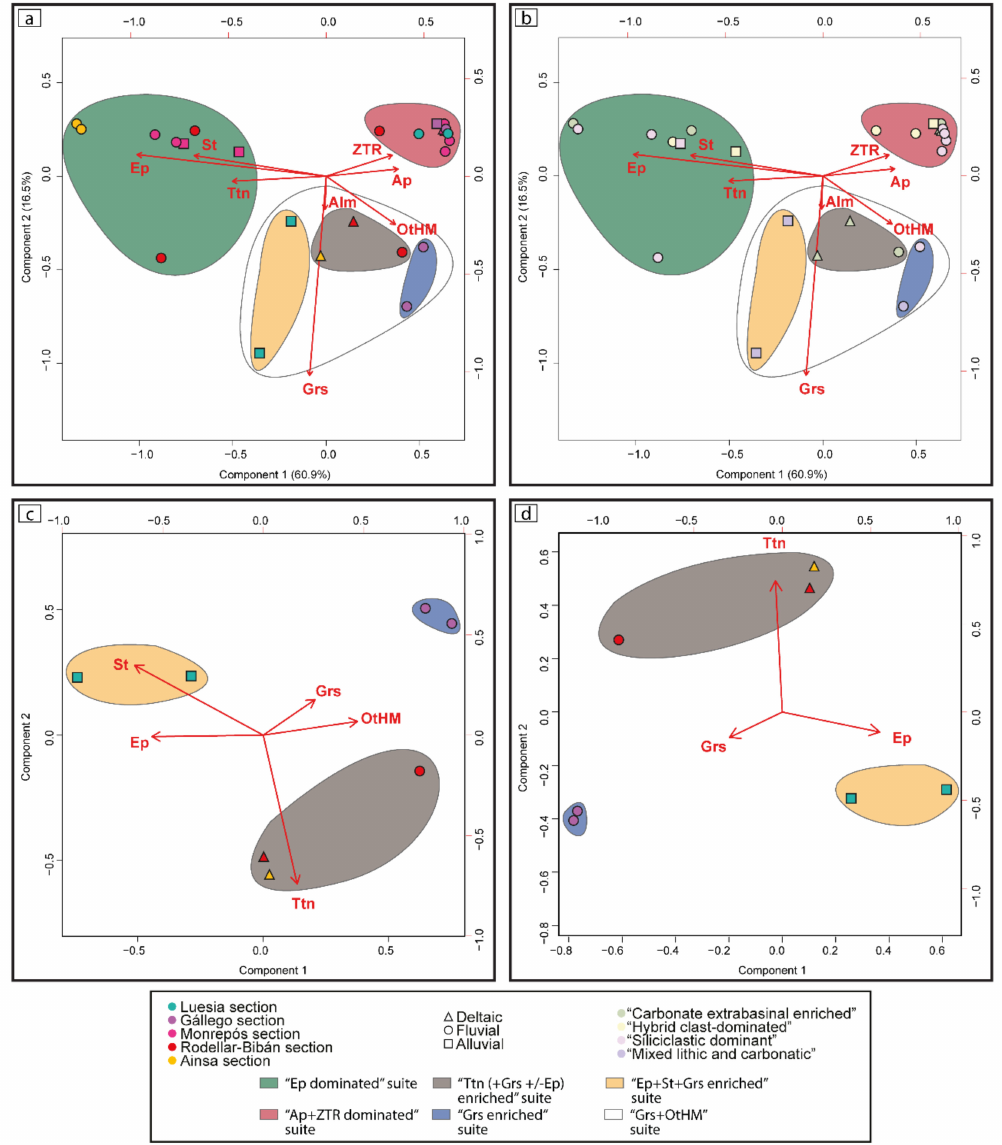
Figure 7. Heavy-mineral compositional plots. ( a ) Biplot displaying the results of correspondence analysis applied to all analyzed samples and considering all encountered minerals. OtHM include scarce minerals (Mz, Xtm, Cpx, Sp, Sph, Cld, And, and Ky). Colored symbols indicate sample’s section. ( b ) Biplot displaying the results of correspondence analysis applied to all analyzed samples. Colored symbols indicate the petrofacies. ( c ) Biplot displaying the results of correspondence analysis applied to samples belonging to the Grs+OtHM enriched heavy-mineral suite only considering Grs, Ttn, Ep, St, and OtHM. ( d ) Biplot displaying the results of correspondence analysis applied to samples belonging to the Grs+OtHM enriched heavy-mineral suite only considering Grs, Ttn, and